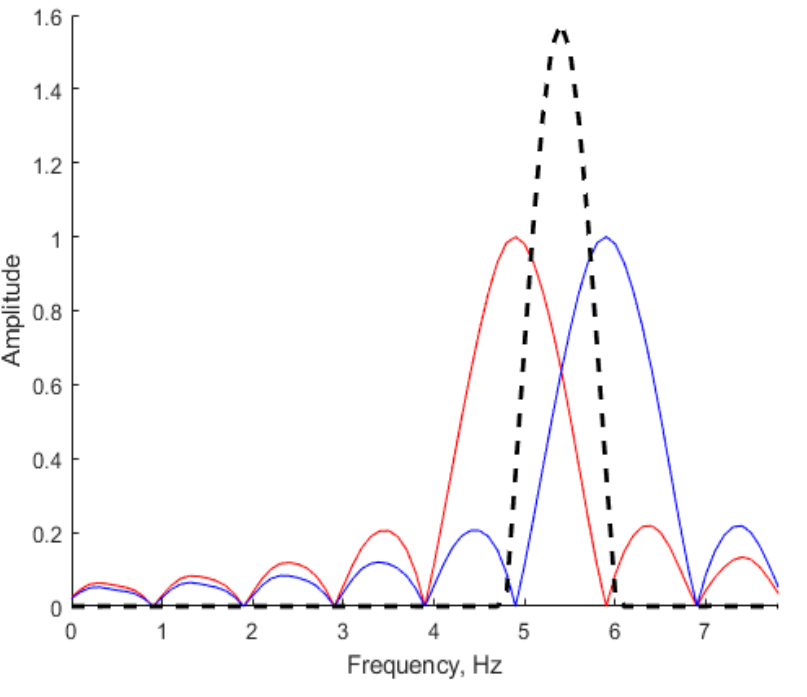
Figure 5. Magnitude response of the DFT and NC channels.